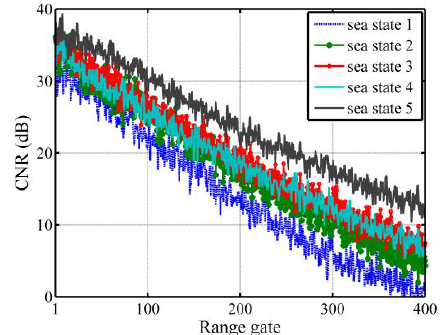
Figure 14. The CNR corresponding to different range gates.